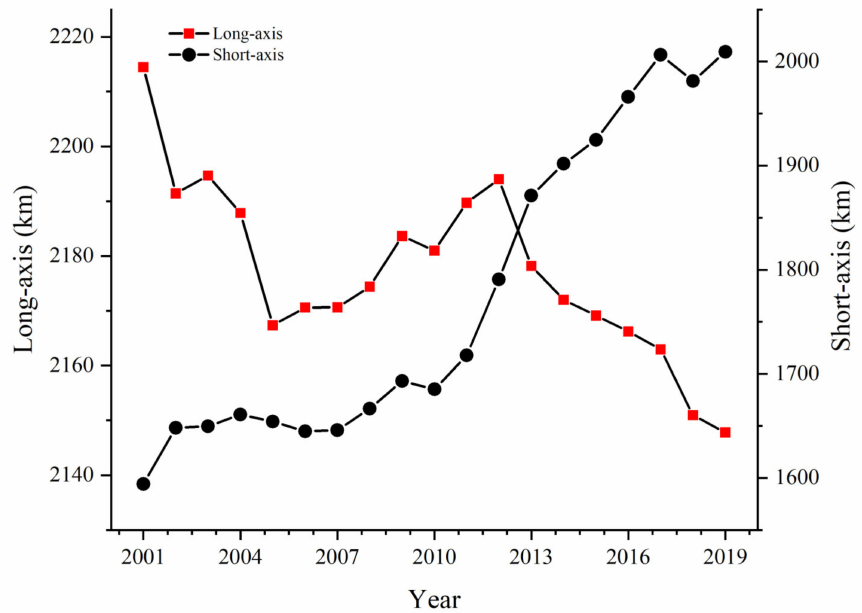
Figure 10. SDE long-axis and short-axis